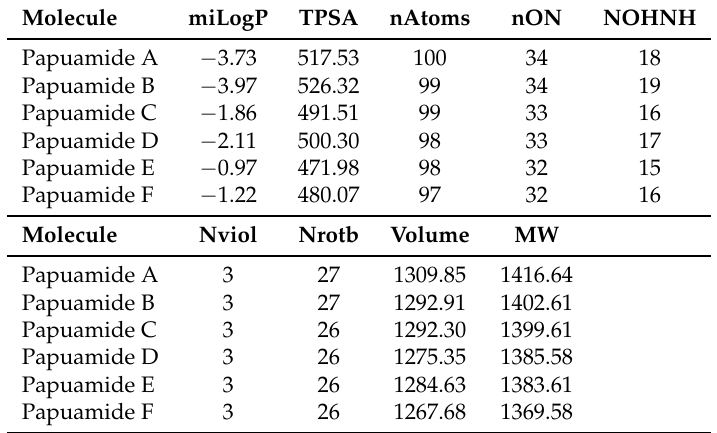
Table 4. Molecular properties of Papuamides A–F peptides calculated to verify the Lipinski Rule of